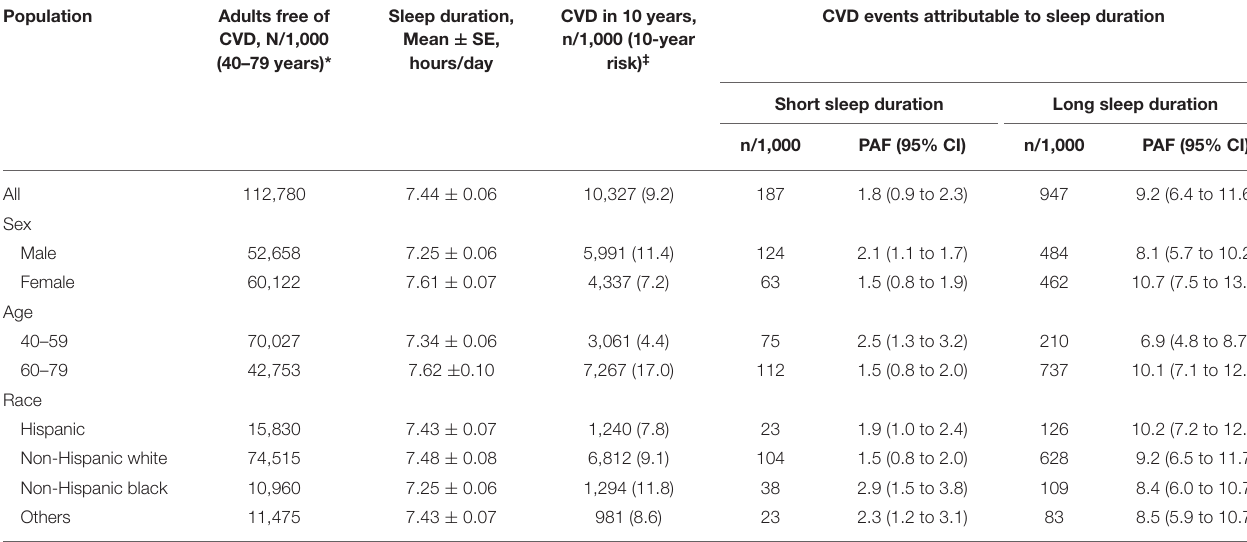
TABLE 3 | The estimated population attributable fraction for cardiovascular disease risk from short and long sleep duration in the United States.